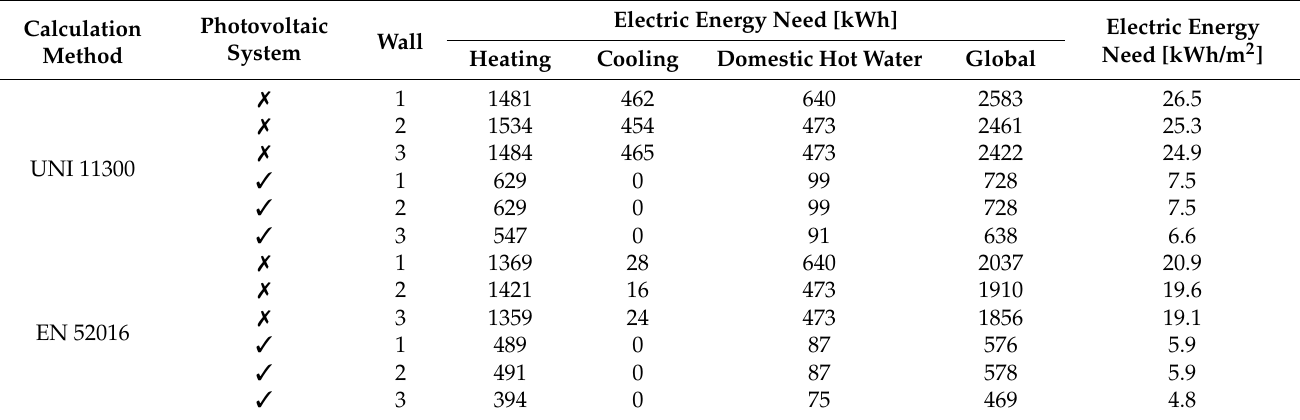
Table 10. Total electric consumption over a year for the three studied